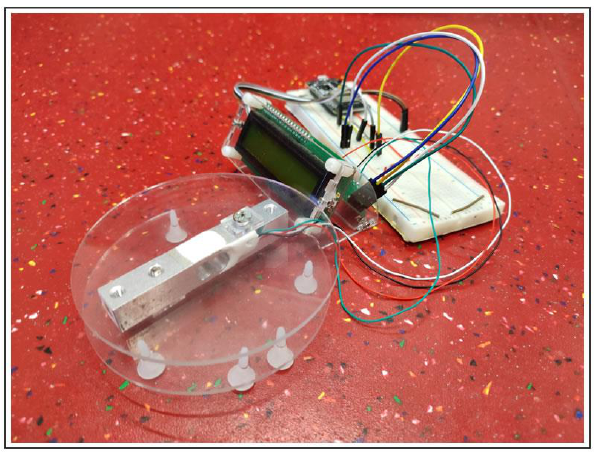
Figure 25. SmartWaste kit.